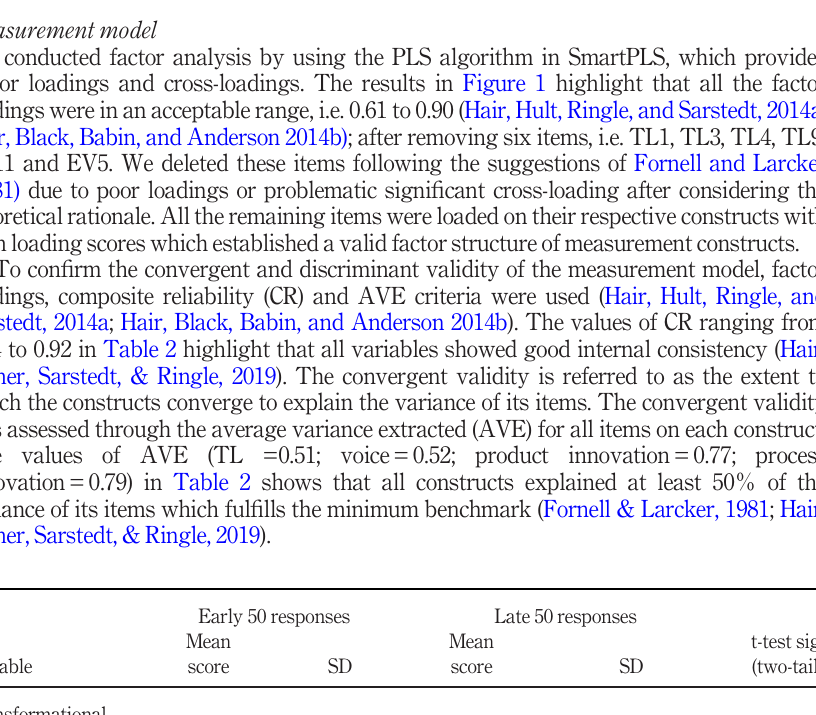
Table 1. Non-response